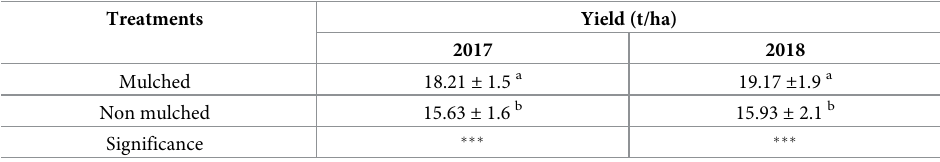
Table 5. Effect of different treatments on tomato yield at Kavre,